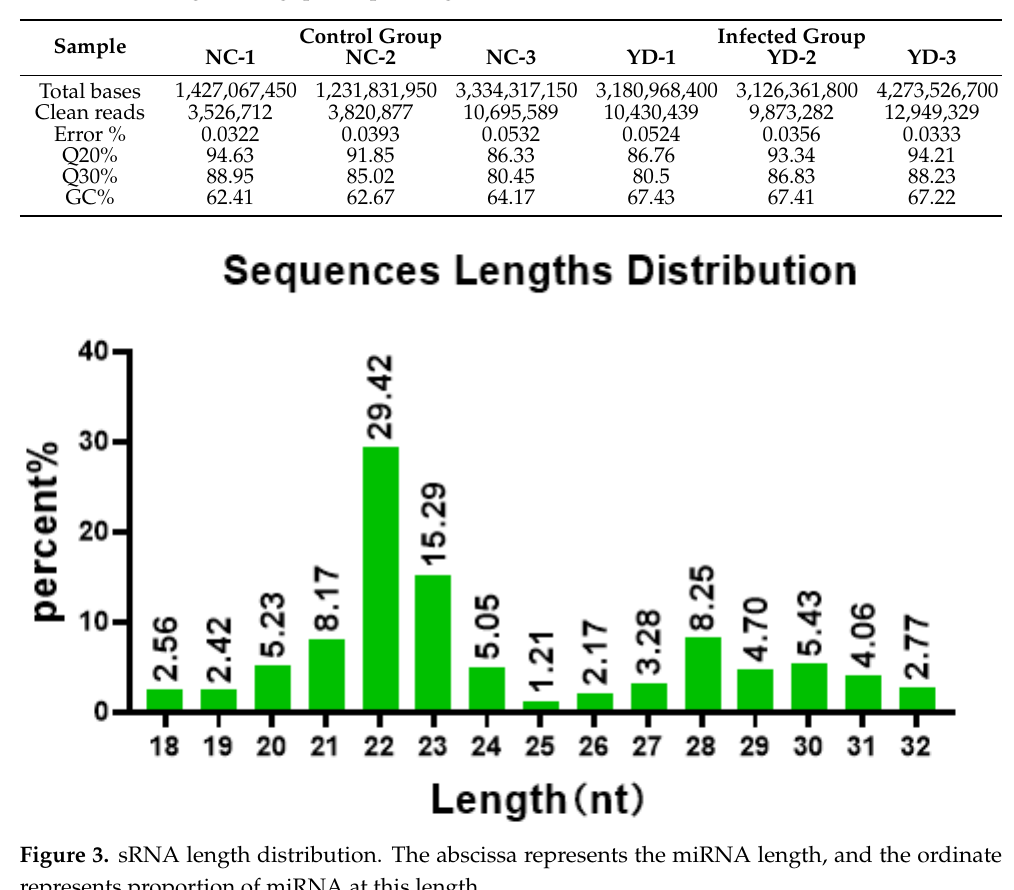
Table 2. sRNA high-throughput sequencing data.